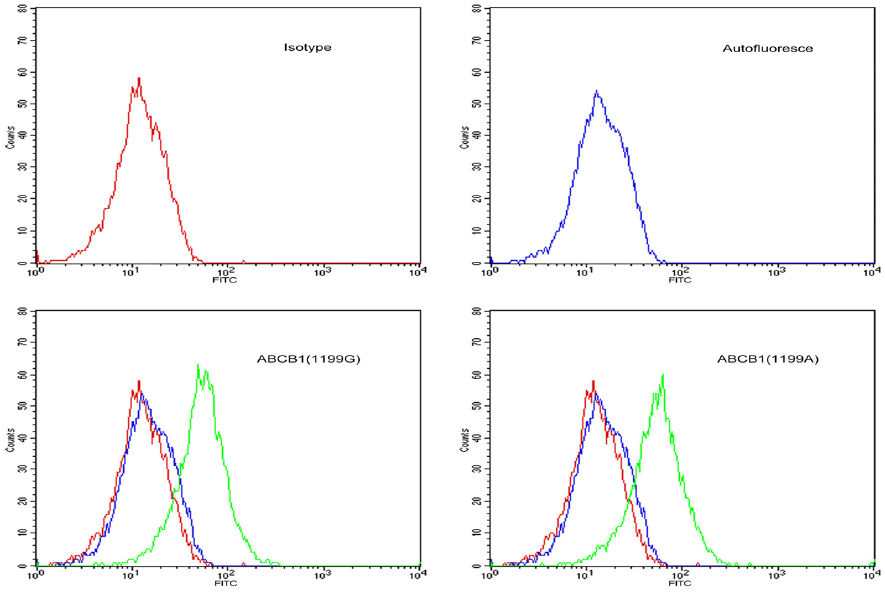
Figure 1. Flow cytometry histograms showing surface expression of P-gp in stably-transfected LLC-PK1 cells expressing the ABCB1 (1199G) or ABCB1 (1199A) allele of P-gp. Untransfected LLC-PK1 cells were also examined as a control. Cells were labelled with FITC-conjugated antibody against P-gp (green line), a matched isotypic control (red line), or left unlabelled (blue